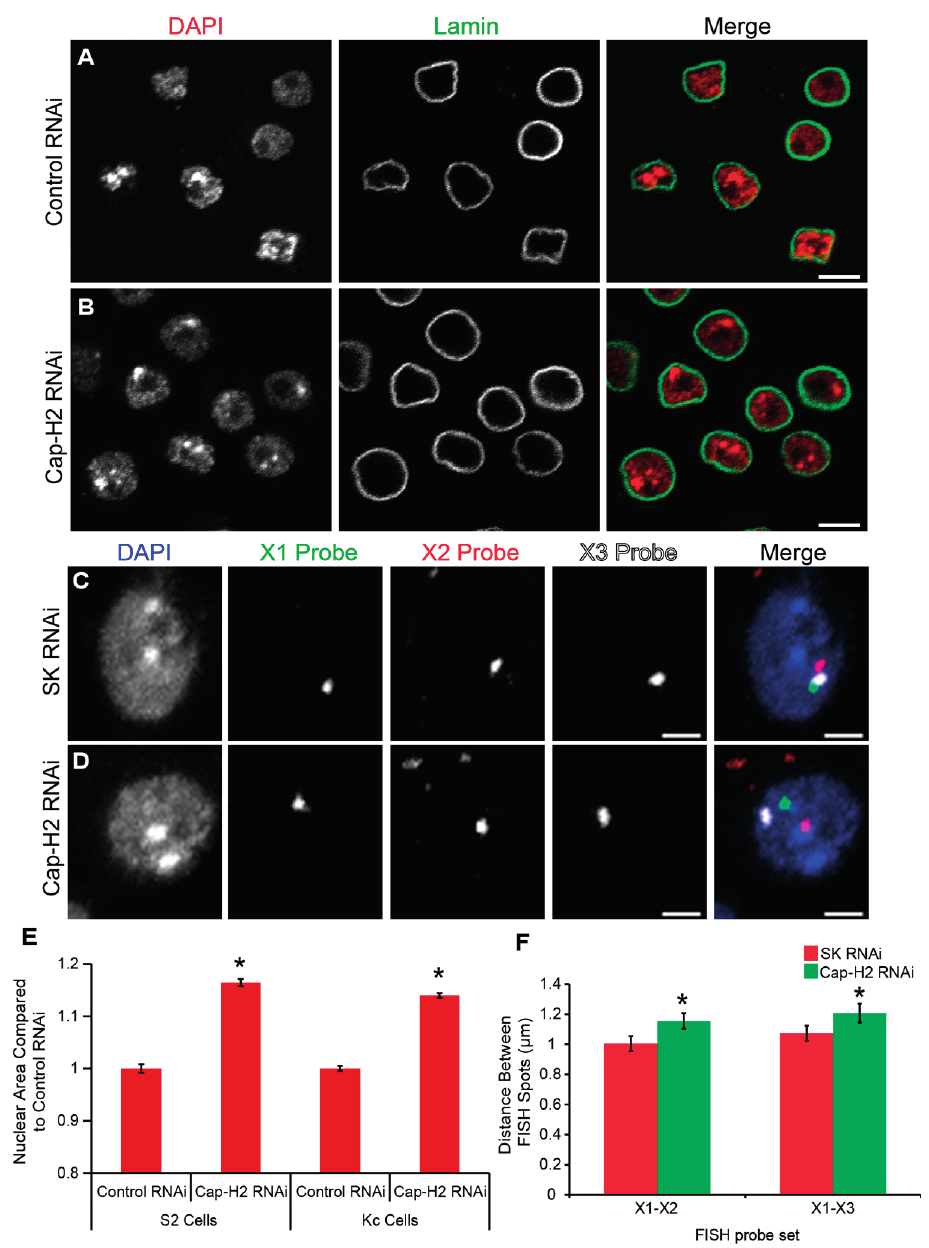
Figure 1. Drosophila condensin II subunit Cap-H2 maintains nuclear size. ( A , B ) Control RNAi ( A ) or Cap-H2 RNAi ( B ) treated Drosophila cultured Kc cells counterstained with DAPI to visualize DNA (red) and immunostained for Lamin (green). Scale bar, 5 µm; ( C , D ) Control (SK) RNAi or Cap-H2 RNAi treated cells and labeled with three different X-chromosome FISH probes. Scale bar, 2.5 µm; ( E ) Graph showing average nuclear area (DAPI signal) of RNAi treated Drosophila cultured cells (S2 and Kc cells). Cap-H2 RNAi significantly increases nuclear area in both S2 and Kc cells. * p < 1.42 × 10 − 52 ; ( n = 3300–9000 cells; two-tailed T-test assuming unequal variance). Error bars indicate SEM; ( F ) Distances in microns ( μ m) between two FISH probe pairs (X1-X2 and X1-X3) measured in 3-dimensional space in Kc167 cells treated with control (SK) or Cap-H2 RNAi. * p < 0.05; ( n = 50 cells for each condition; two-tailed T-test assuming unequal variance). Error bars indicate